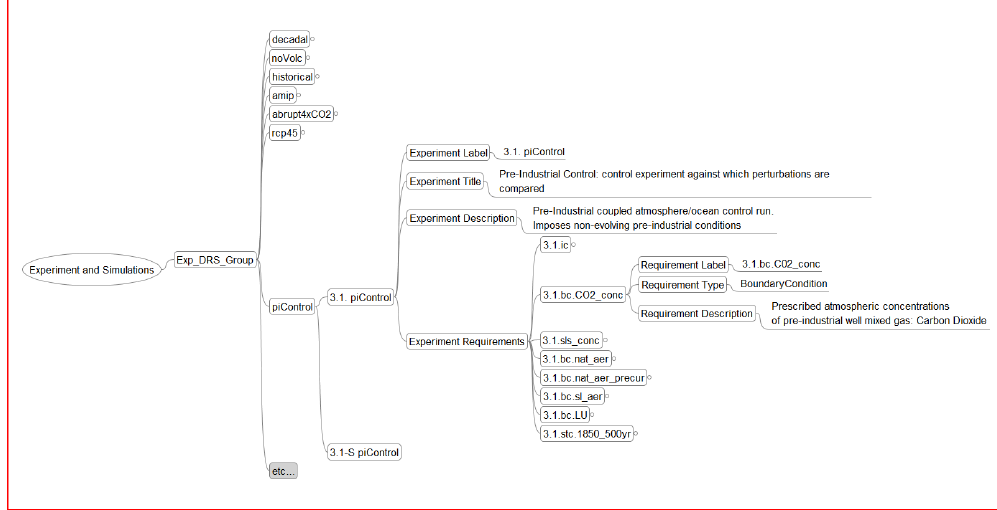
Fig. 4. Tree diagram showing information necessary to identify and document an experiment. Example shown is the CMIP5 pre-industrial experiment. The experiment is identified by a label, a title, an associated description and the list of requirements to be fulfilled by the simulations that instantiate this experiment. Each requirement is in its turn identified by a label, a type and a description. Value (text) for these attributes is fixed once and for all by the CMIP5 experiment protocol. Notice that this tree diagram is just illustrative (it is not a CV